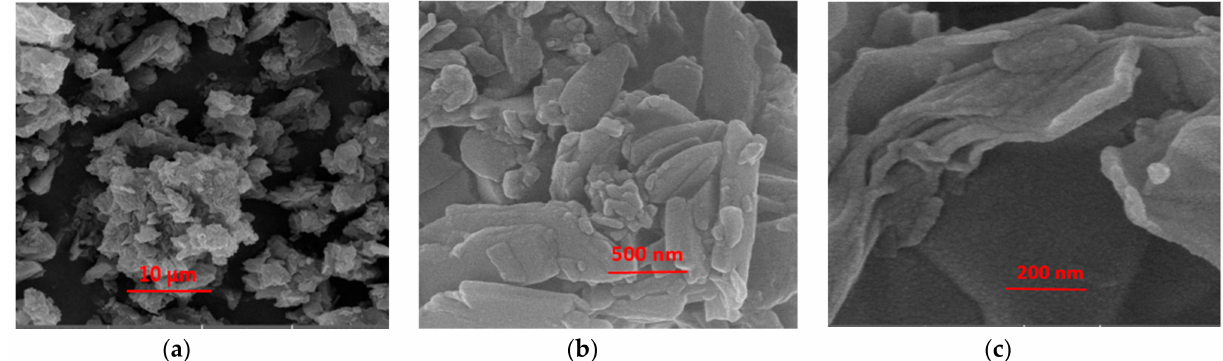
Figure 4. Field emission scanning electron microscopy (FESEM) pictures with different magnifications of m-GO ( a – c ).